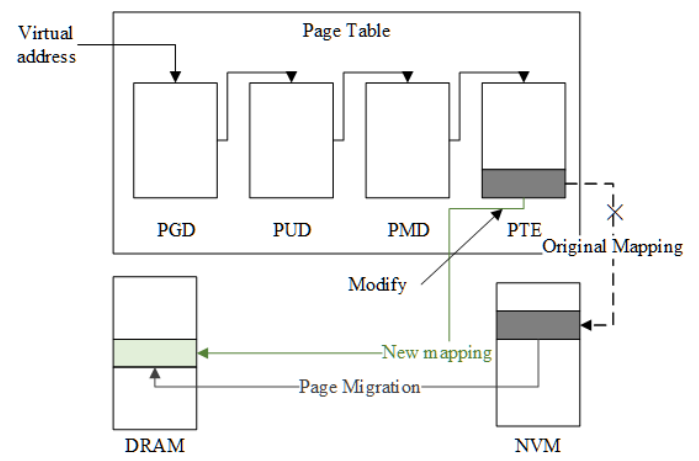
Figure 5. The page migration process in the parallel architecture.